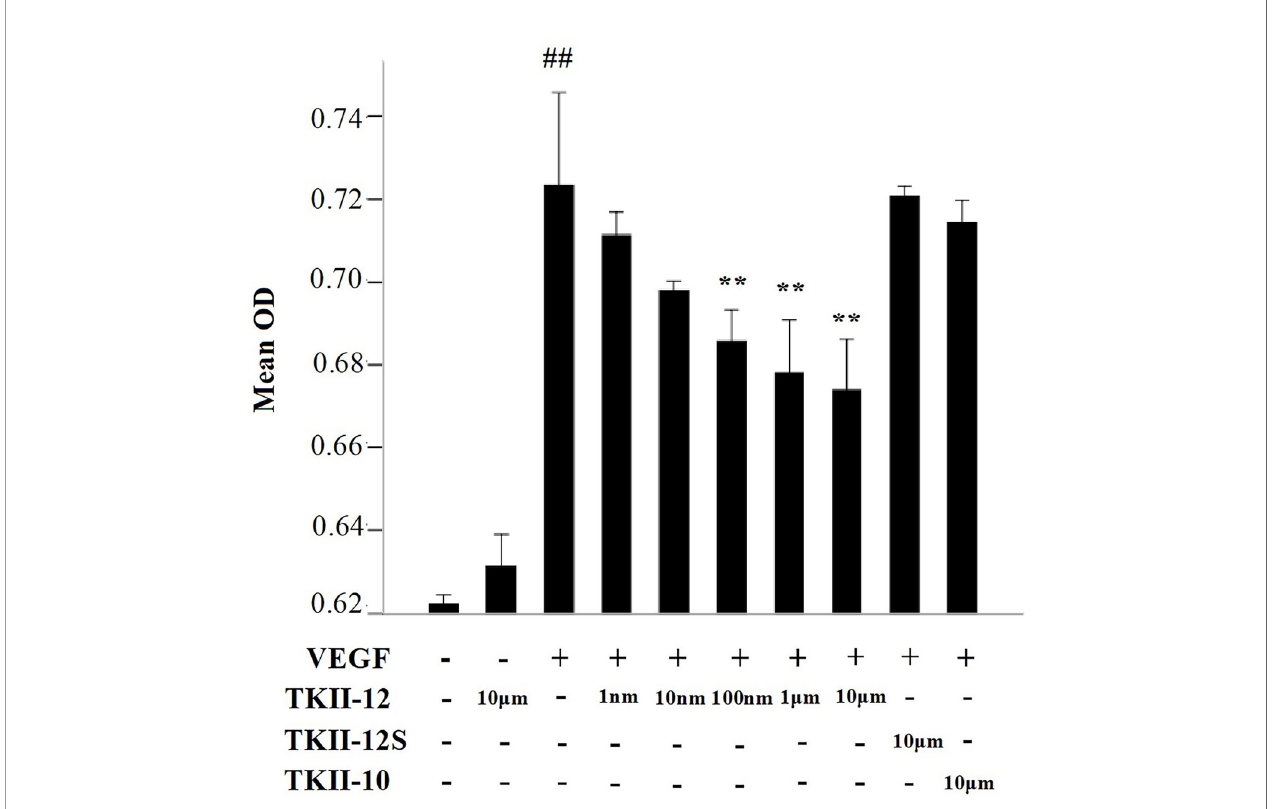
FIGURE 2 | Effects of TKII-12 on vascular endothelial growth factor (VEGF)-induced (HRMECs proliferation in vitro . Inhibitory effect of TKII-12 on endothelial cell proliferation was assessed by MTS method 24 h after treatment. Each value represents the mean ± SEM of triplicate measurements. ** p < 0.01 versus the VEGF group. ## p < 0.01 versus the control